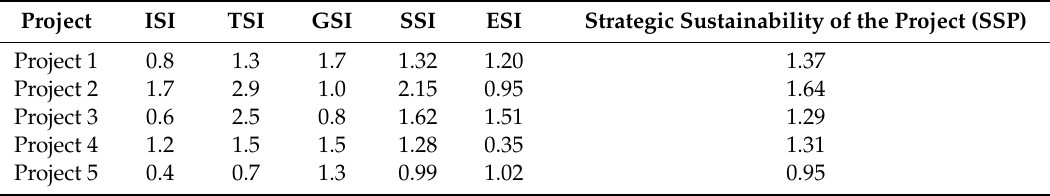
Table 7. Calculation of the strategic sustainability of the Company’s o ff shore projects.